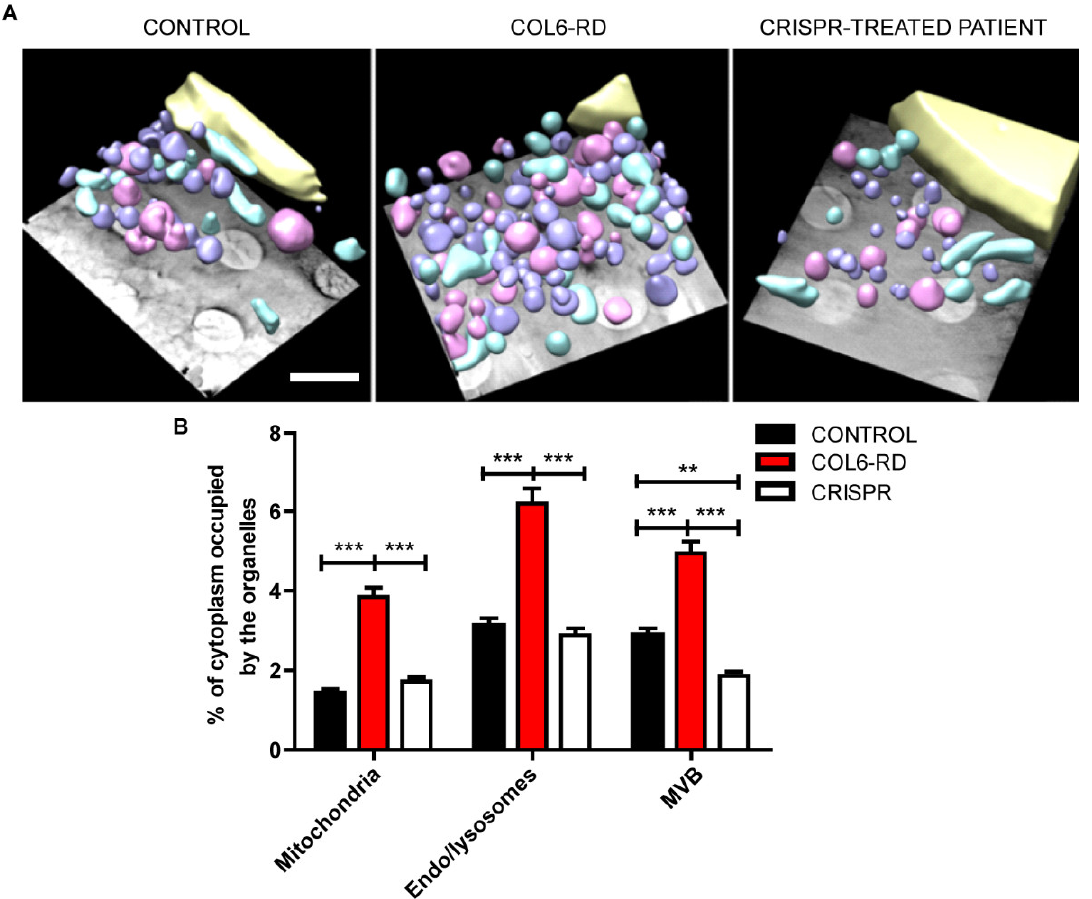
Figure 2. Altered abundance of mitochondria, endo/lysosomal-like vesicles, and multivesicular bodies in COL6-RD patients’ cells. ( A )Three-dimensional reconstruction of whole-cell volumes of control-, andCOL6-RD patient-derived fibroblasts and CRISPR-treated fibroblasts. Threshold-based isosurface segmentation of the surface boundaries identifies the different organelles present in the cells: nucleus in yellow, mitochondria in light blue, endo/lysosomal-like vesicles in violet, and multivesicular bodies in pink. ( B ) Quantification of the percentage of cytoplasm occupied by the organelles analysed. Data are expressed as the mean ± SEM; n = 10; different cells (10 CONTROL cells, 10 COL6-RD cells, and 10 CRISPR samples) were used for all panels. ** p < 0.01, *** p < 0.001; Two-way ANOVA/Bonferroni’s multiple comparison test. Scale bar 500 nm.